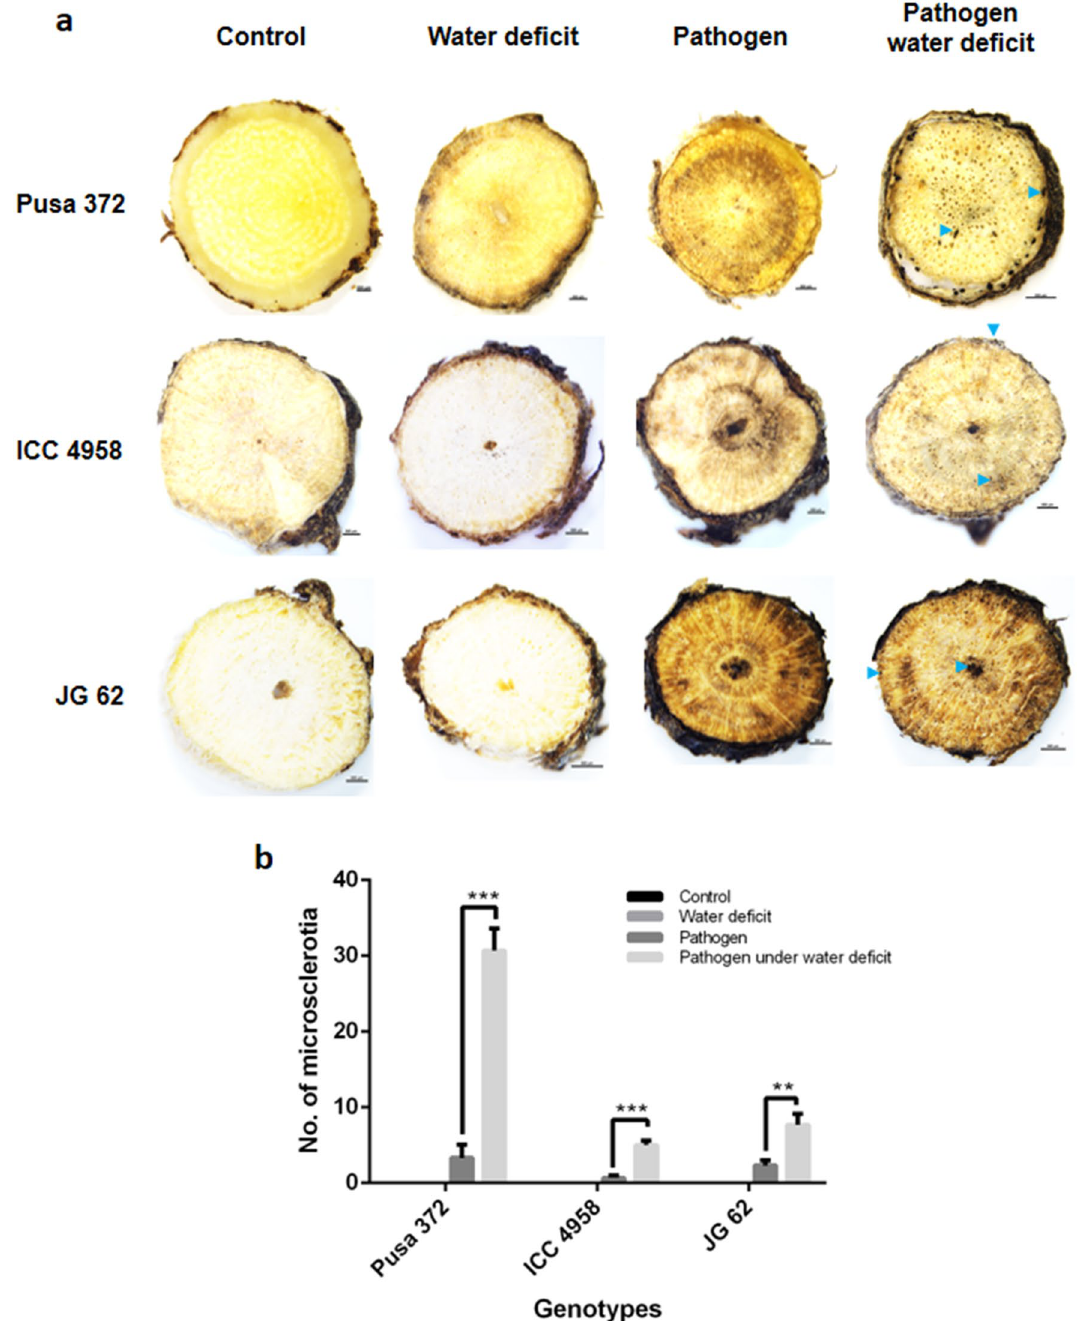
Figure 5. Low soil moisture aggravates the DRR incidence in various chickpea genotypes. Chickpea genotypes PUSA 372, ICC 4958 and JG 62 were used to explore the impact of soil water deficit stress on DRR disease incidence. The experiment was conducted during the rabi season (October to March, 2019–2020). Plants were imposed with LSM, PS, and CS treatments and along with control. Plants were uprooted at the time of maturity and examined for the presence of microsclerotia in the root. Handmade root sections were made at 2 cm from the point of seed attachment. Microsclerotia present on the root was counted. Images ( a ) show the transverse section of three genotypes in all the treatments and control. Graph ( b ) shows the number of microsclerotia in the root sections. Images were captured under the 0.5X objective lens of the research stereo microscope SMZ25. Scale bar is 500 µm. N = 3. Significance difference was determined using one-way ANOVA (p < 0.0001) and the asterisk represents the significance. Blue arrows show the microsclerotia. LSM, low soil moisture; PS, pathogen stress; CS, combined low soil moisture and pathogen